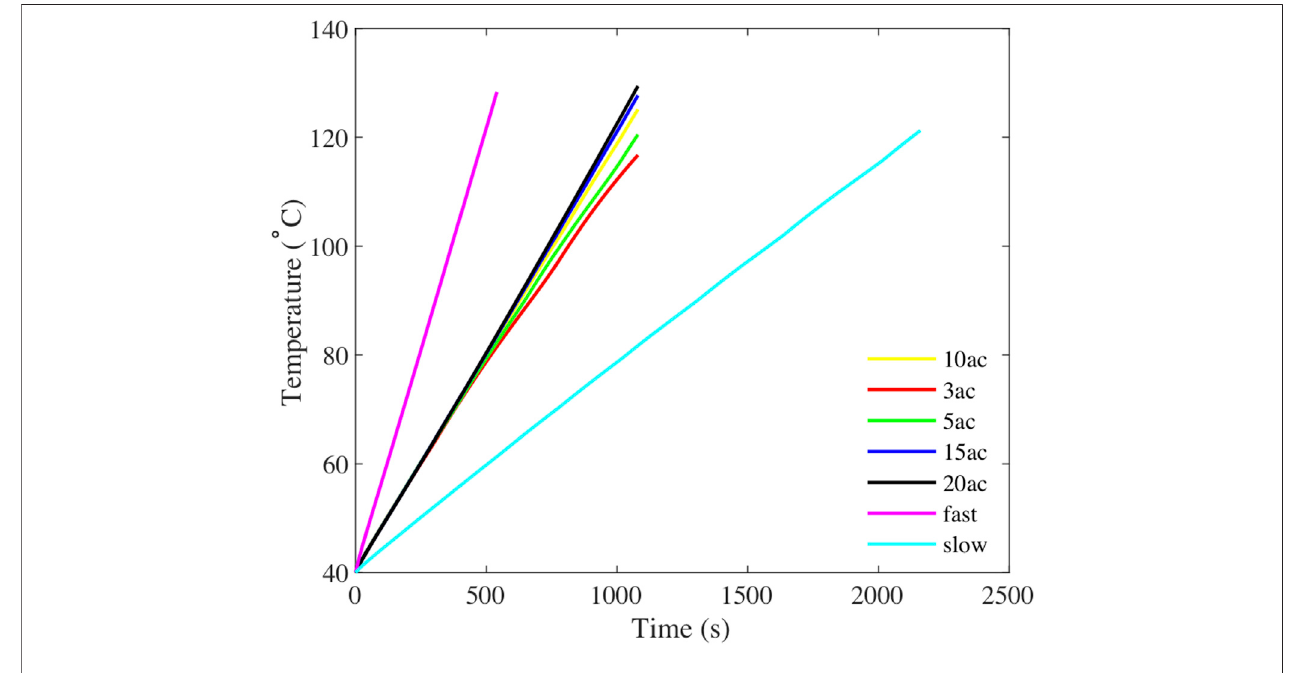
FIGURE 8 | Nitrogen temperatures of IHESS in different cases.